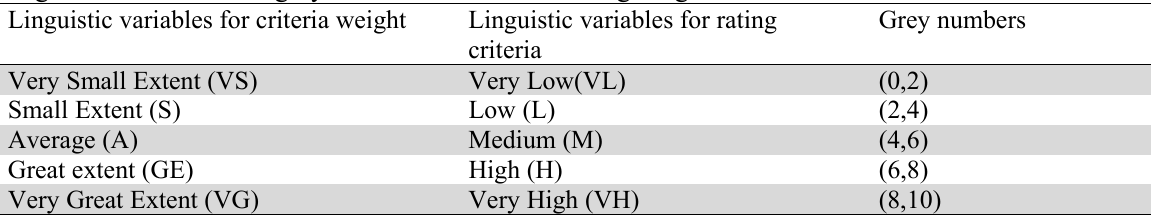
Linguistic variables and grey numbers for Criteria